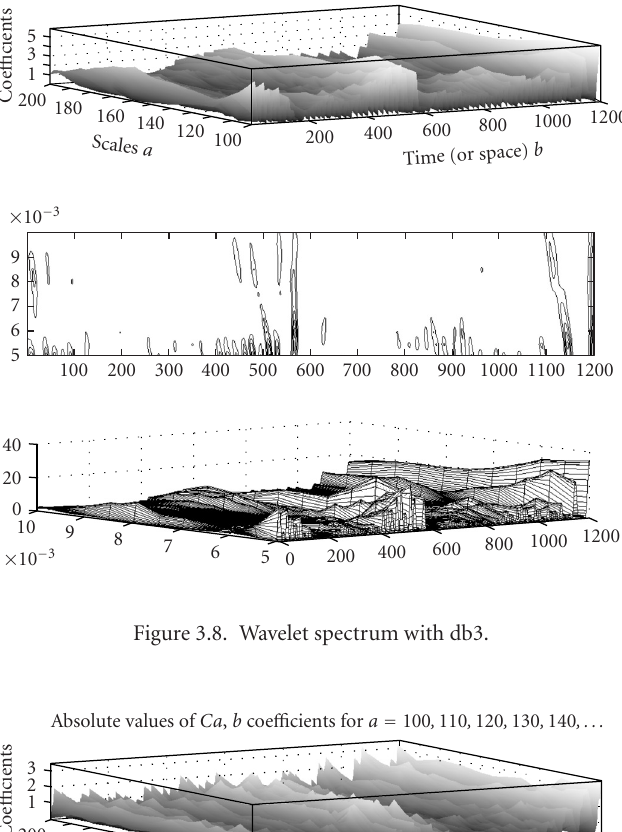
Figure 3.8. Wavelet spectrum with db3.